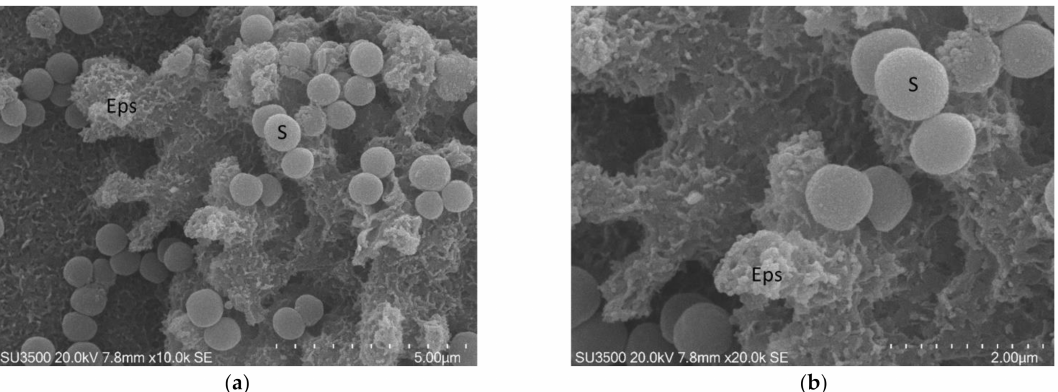
Figure 2. S. mutans prepared by conventional SEM procedure. ( a ) SEM, 10,000 × . Eps forms a canalicular system of compact trabeculae with spiny surface. Bacterial cells, S, are adherent to the Eps surface. Eps: extracellular polymeric substance. Image was captured from the same sample observed in [50] Figure 1d; ( b ) SEM, 20,000 × . Bacterial cells appear irregular, Eps micro-canalicular system is not developed, only superficial holes are visible. Bacterial cells lay down on the Eps surface, and they appear naked, without a matrix covering. Bacterial cells are sometimes fragmented or indented; Eps showed a compact aspect due to the collapse of its fine structure. Bacterial cells, uncovered by the matrix, rest on the Eps surface. Eps: extracellular polymeric substance, S: S. mutans . Image was captured from the same sample observed in [50]. Figure